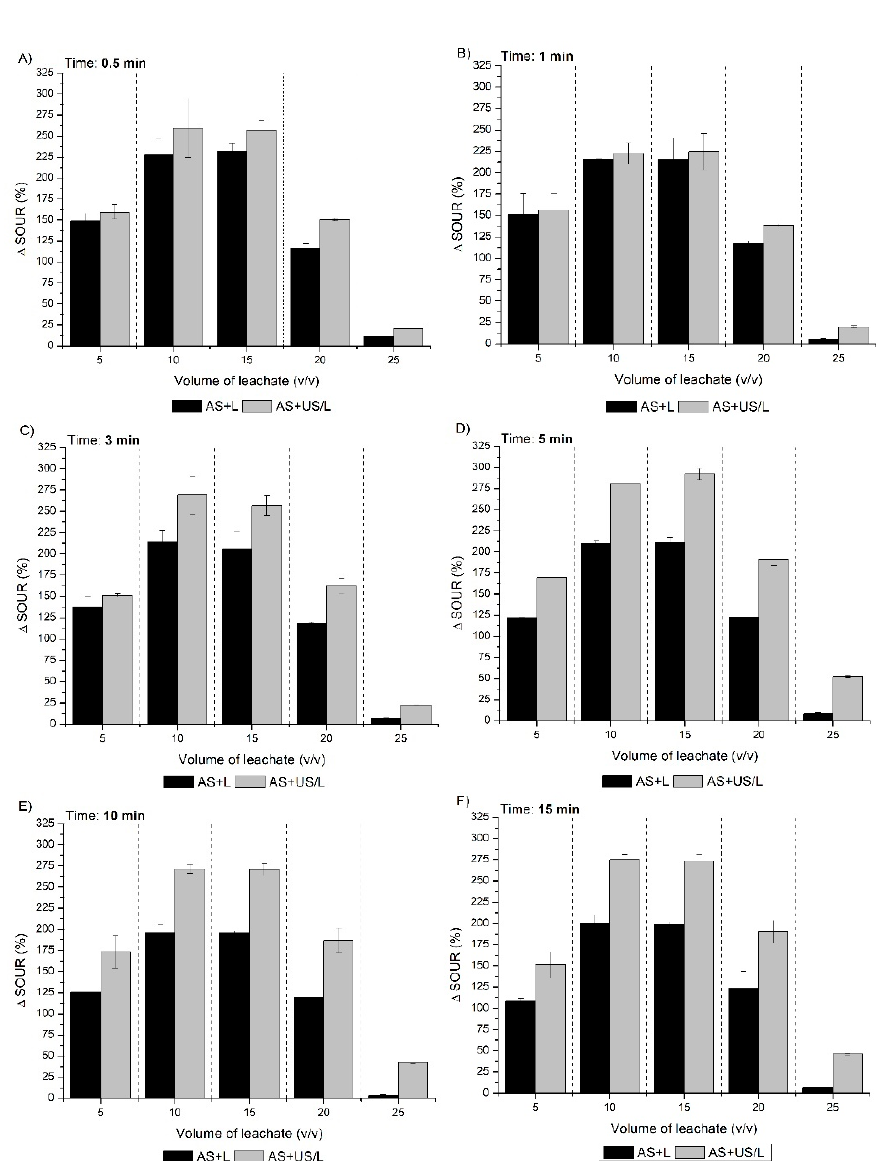
Figure 5. Variation of Δ SOUR at different volumetric ratios of leachate in the mixture and sonication time of: ( A ) 0.5 min; ( B ) 1 min; ( C ) 3 min; ( D ) 5 min; ( E ) 10 min; ( F ) 15 min (vertical bars denote +/ − standard errors; AS + L—Activated sludge + leachate without pretreatment; AS + US/L—Activated sludge + leachate with pretreatment). Table 6. Results of factorial ANOVA for Δ DHA activity Δ SOUR (*—interaction between factors).